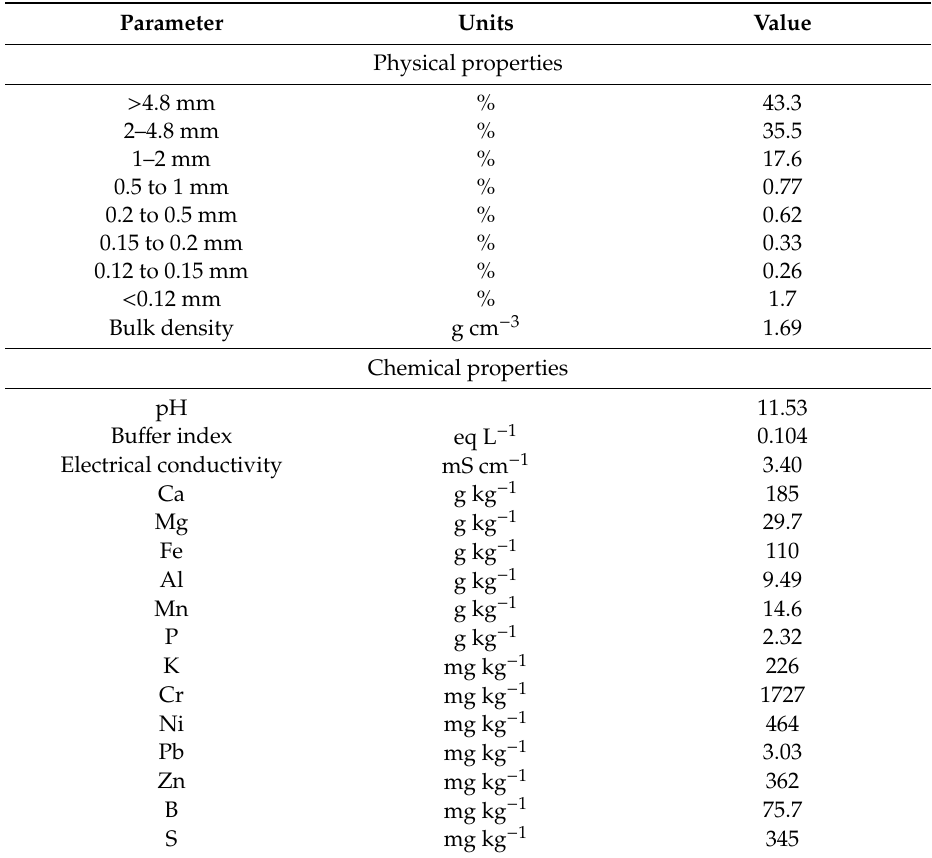
Table 1. Physical and chemical properties of the slag used in both field P removal structures and laboratory flow-through experiments. Concentrations of elements are total